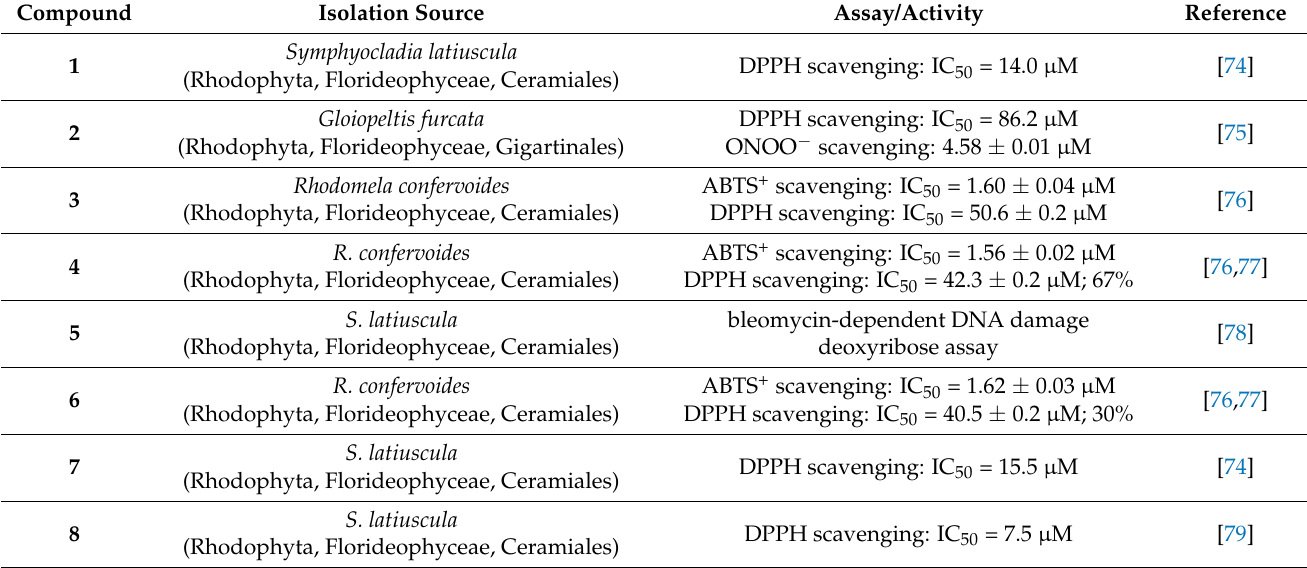
Table 2. Phenolic compounds from macroalgae with antioxidant